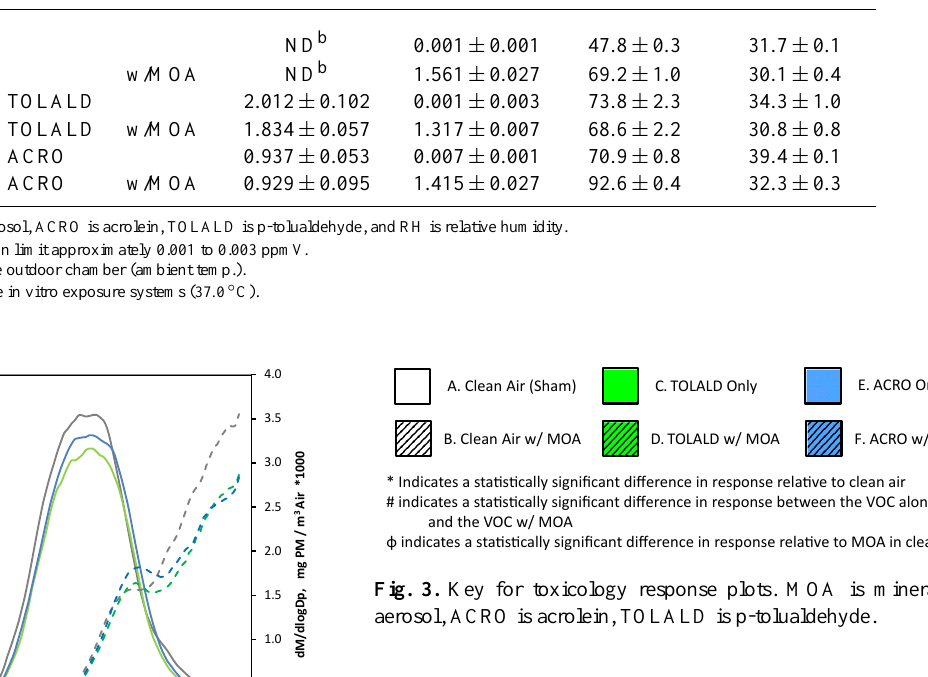
The relative inflammatory responses to the mixtures that contained TOLALD are given in Fig. 4. The only